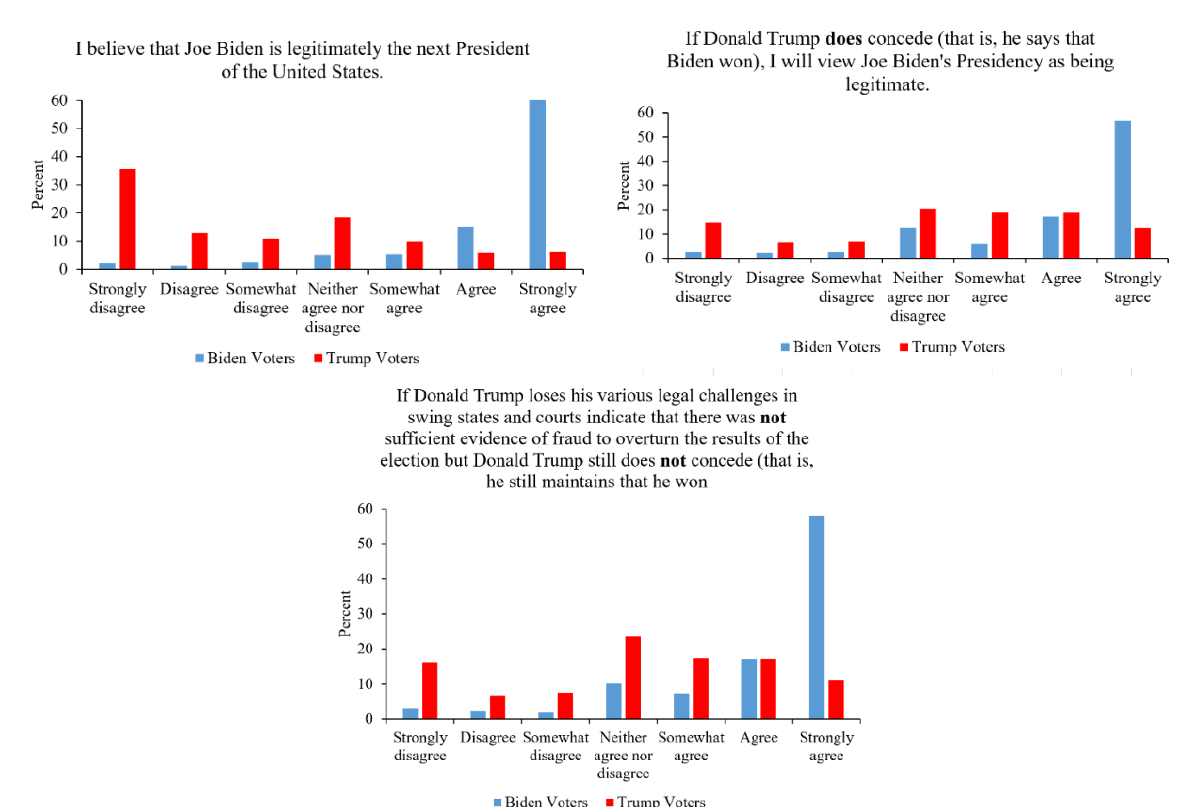
Figure 3. Testing the strength of the belief that Trump won. Few Trump voters believe that Biden has been legitimately elected President (22%). However, many Trump voters would view Biden’s Presidency as legitimate if Trump concedes (51%) or does not concede but loses his various legal challenges